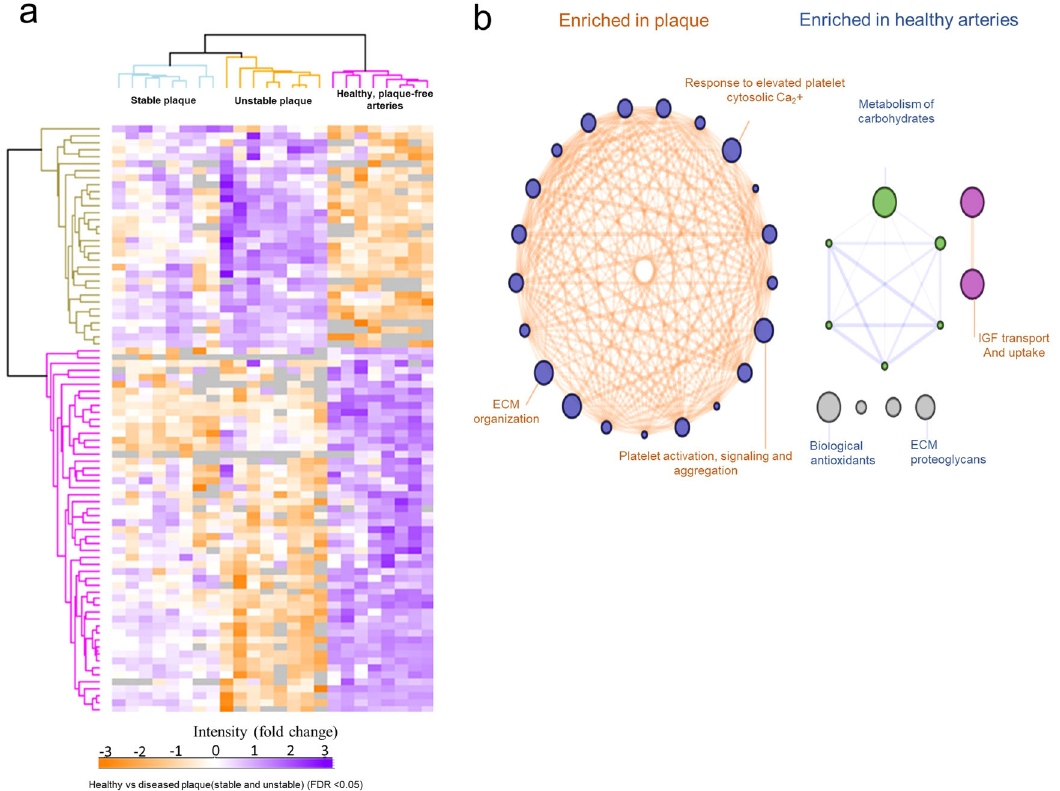
Fig. 2 Differential proteome analyses of atherosclerotic (unstable and stable) arteries versus healthy, plaque-free arteries. a Hierarchical clustering of differential protein expression across all tissue regions, comparing diseased plaque (stable and unstable) to the healthy vessels ( n = 8). Proteins identi fi ed in at least 70% within each tissue group (at least 5/8 samples), FDR < 0.05, 32 proteins highly expressed in plaque (purple), 53 proteins lowly expressed in plaque (orange). b Enrichment map of Reactome pathway terms overrepresented in atherosclerotic plaques (stable and unstable) in comparison to healthy